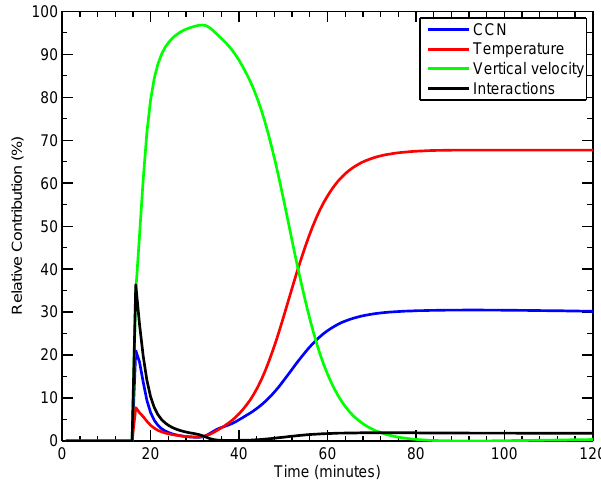
Fig. 11. As Fig. 9 but for the 2-m A-R scheme with modified fallspeed parameter for rain, such that b r is increased from the default value of 0.8 to 0.825. All other fallspeed parameters are unchanged.